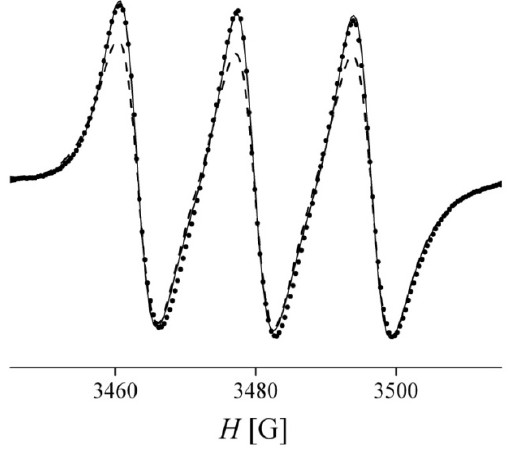
Figure 4. EPR spectrum of TEMPOL radical in magnetoanisotropic polyacrylamide gel ( f = 9.763559 GHz). Dots: experimental spectrum. Solid line: theoretical spectrum calculated for elongated aggregates. Dashed line: theoretical Lorentz